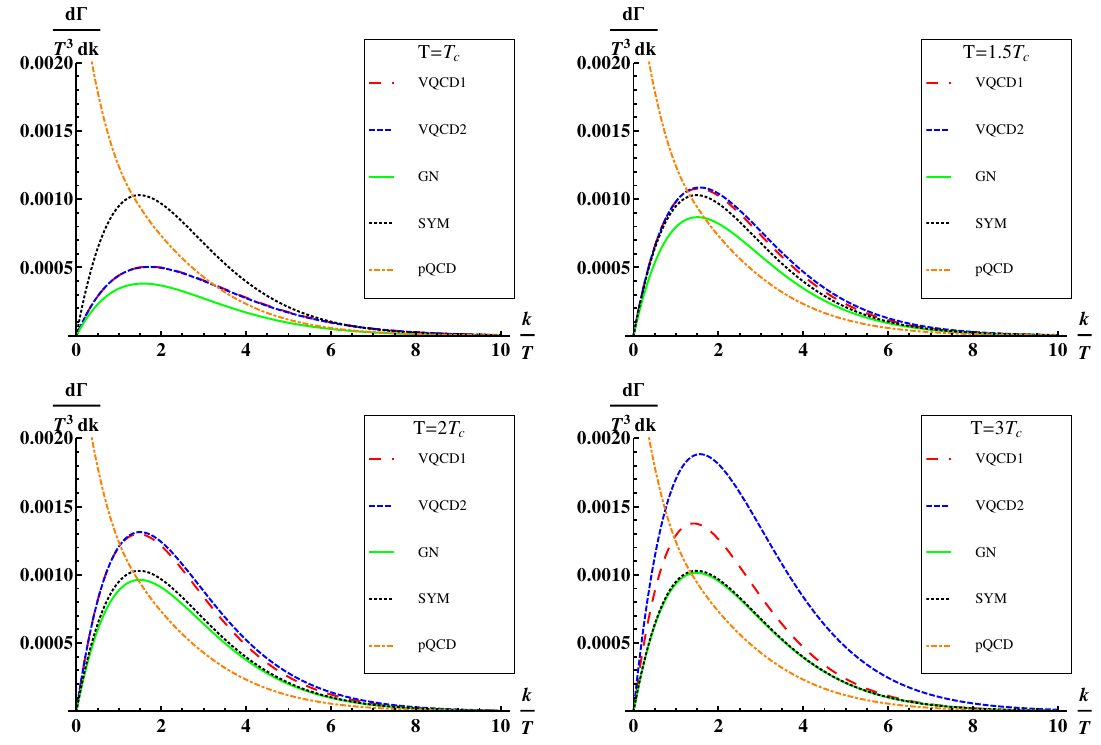
Figure 2 . Photon-emission rates from di(cid:11)erent models. The pQCD rates are for the weakly coupled QGP at g s = 2 at next-to-leading